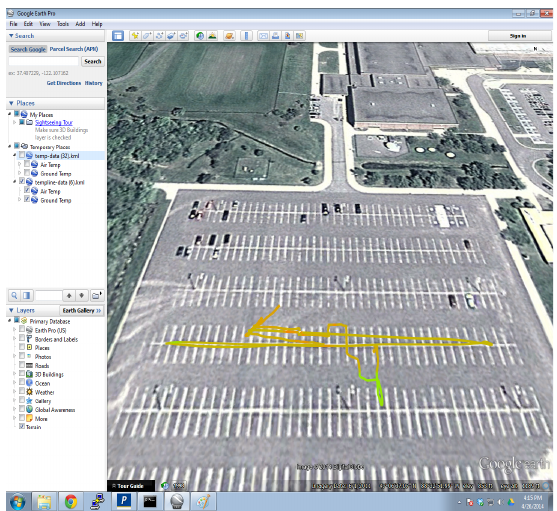
Figure 6. Orthorectified visualization of imagery using MicMac software .